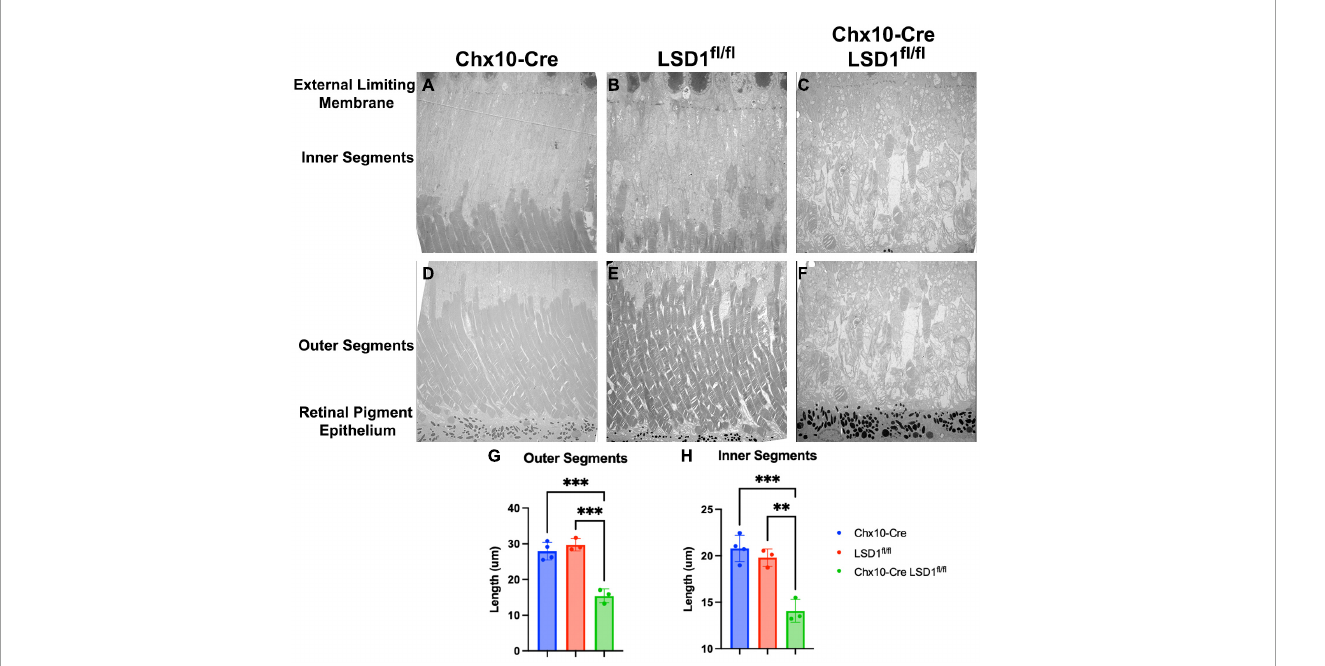
FIGURE5 Electron microscopy of the area between RPE and external limiting membrane (ELM) show decreased lengths of inner and outer segments in Chx10-Cre Lsd1 fl / fl animals compared to controls. Using 1400X magnification, we observed disorganization and significant reductions of the inner and outer segments lengths (C,F) ; however, no abnormalities were observed in the Chx10-Cre only controls (A,D) or the Lsd1 fl / fl only controls (B,E) . Additionally, no abnormalities, such as drusenoid like deposits or vacuoles, were observed in the ELM, RPE, or choroid in any mouse strain. Statistically significant decreases in the outer segment length (G) and inner segment length (H) were observed in Chx10-Cre Lsd1 fl / fl animals compared to controls. Two–Way ANOVA with Tukey’s multiple comparisons test. **Represents p -value < 0.01; ***represents p -value < 0.001. Samples sizes: Chx10-Cre ( n = 4), Lsd1 fl / fl ( n = 4), Chx10-Cre Lsd1 fl / fl ( n = 5). Full list of statistical results can be found in Supplementary Tables 11, 12